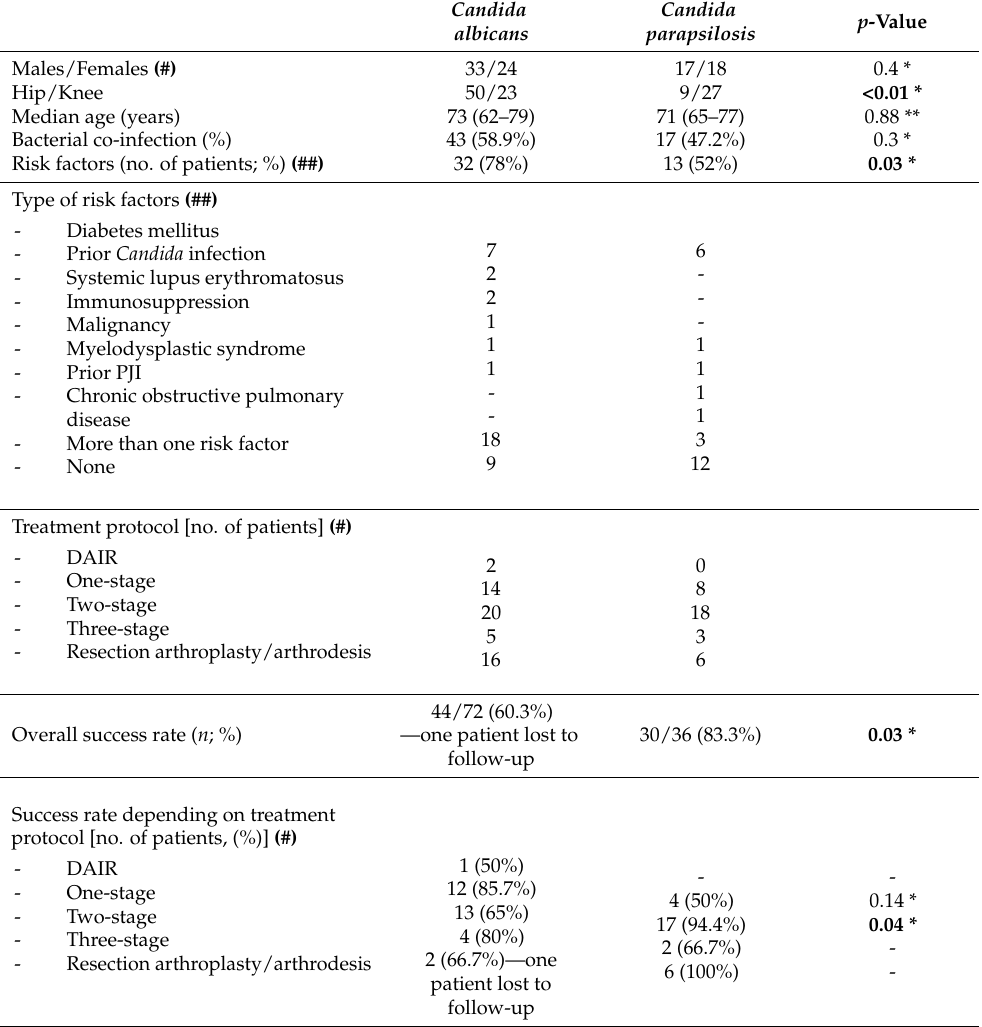
Table 3. Comparison of Candida albicans and Candida parapsilosis fungal PJIs. Data were extracted from the literature included in the systematic review. Continuous values are presented as median with Interquartile Range